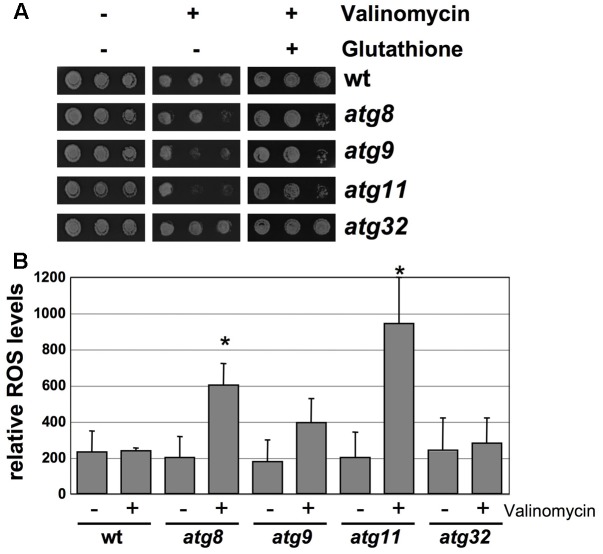
Loss of autophagosomal functions impairs adaptation to valinomycin. (A) The indicated yeast strains were grown in YPGal medium and treated or not with 4 μM valinomycin in the presence or absence of 5 mM glutathione for 12 h in serial dilutions. Colony formation was then assessed on YPD agar plates. (B) Reactive oxygen species (ROS) in the same yeast strains. The 2′7′-dichlorodihydrofluorescein diacetate assay was performed before and after treatment with valinomycin (4 μM, 2 h). Data represent the mean values from three independent assays. Significantly increased ROS levels relative to wt are marked. ∗p < 0.05 (Student’s t-test).